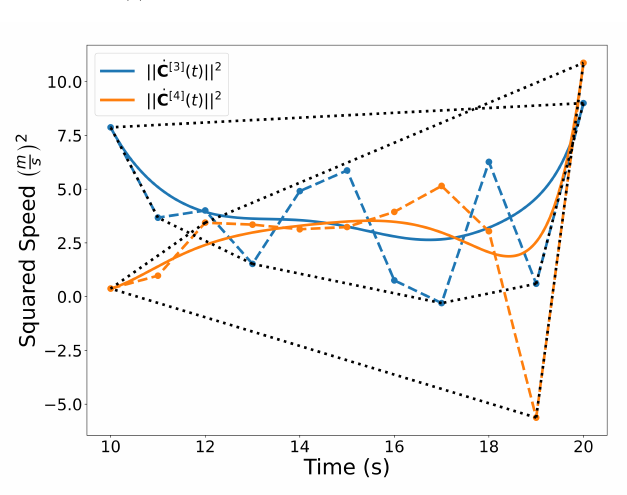
Figure 14. Convex hull drawn around the elevated Bernstein coefficients of trajectories C [ 3 ] ( t ) and C [ 4 ] ( t ) .